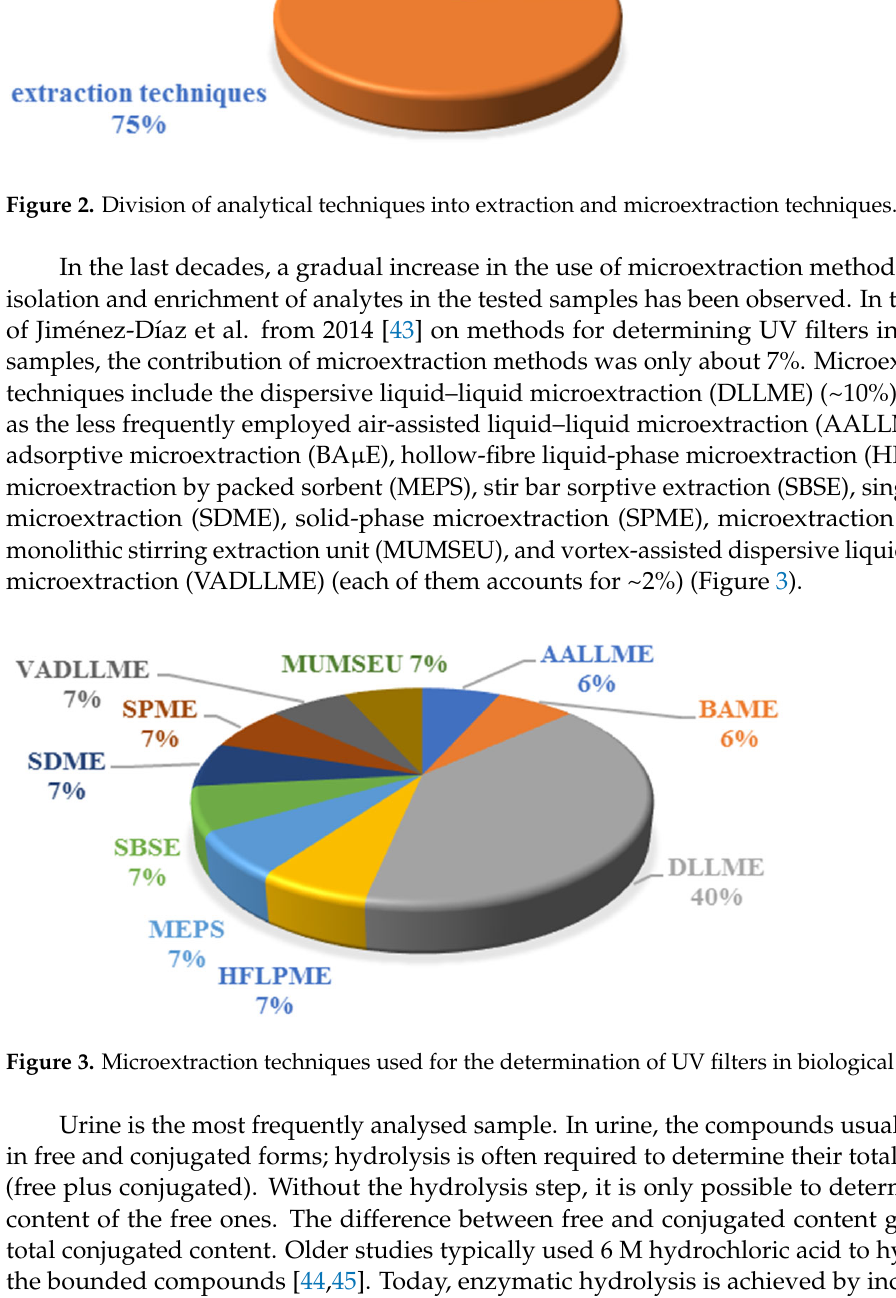
Figure 3. Microextraction techniques used for the determination of UV filters in biological samples.